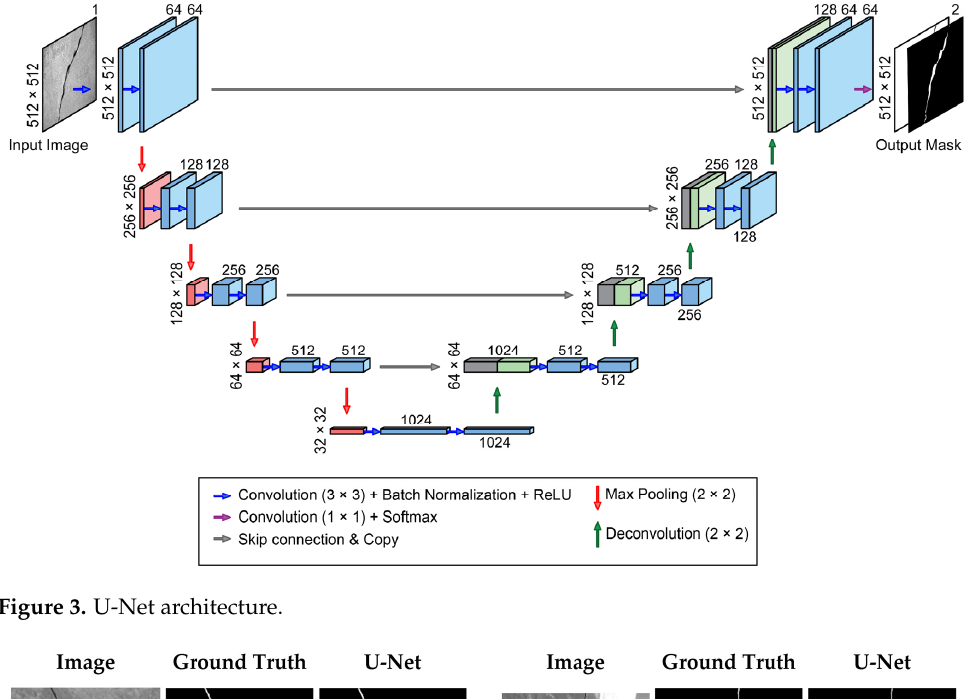
Figure 3. U-Net architecture.